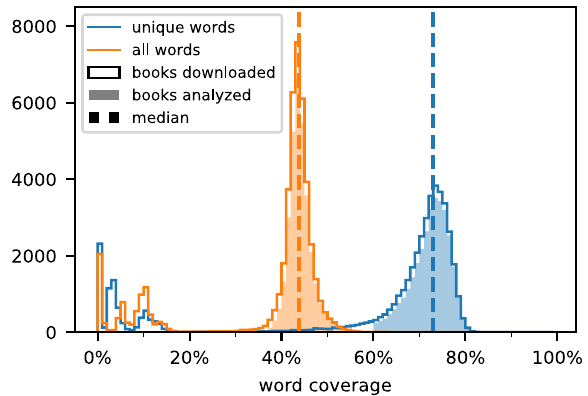
Fig. 5 Word coverage of the PDS lexicon. The blue histograms correspond to the unique word coverage, while the orange histograms correspond to the word coverage allowing for word repetition. We show the histograms for all the books downloaded in our dataset (empty bars) as well as those we analyzed (shaded bars), and the dashed lines show the median word coverage of the books analyzed. The books included in our analysis do not include duplicate titles and must have (1) a unique word coverage of at least 60%, (2) at least one lexicon word in every window, and (3) intrinsic mode functions (IMFs) that can be successfully